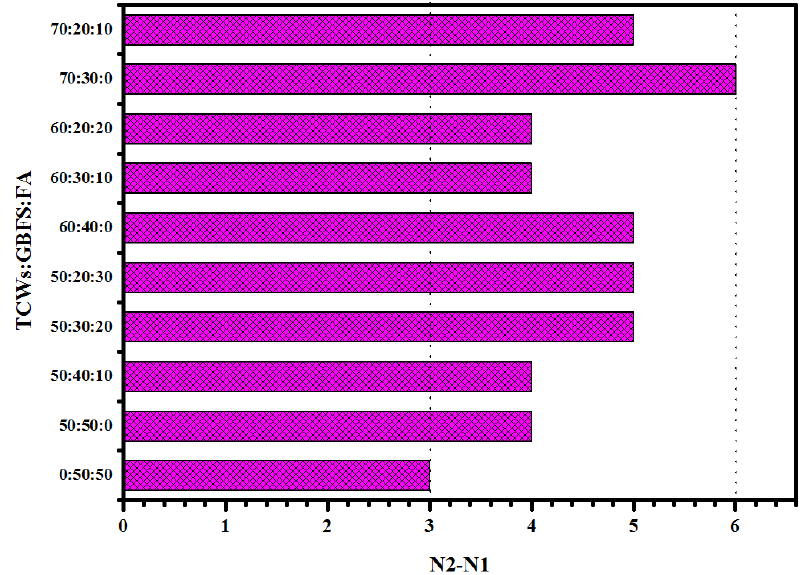
Figure 14. Variation of IR (N 2 -N 1 ) as a function of DRTCs content.